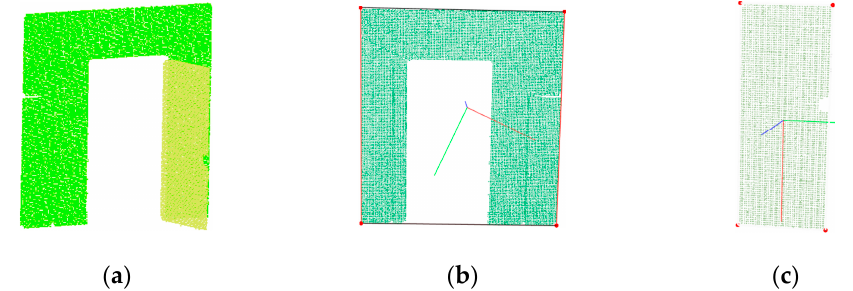
Figure 8. Corner points of the wall in Livingroom. ( a ) Original scene; ( b ) plane1; ( c ) plane2; ( d ) plane3.